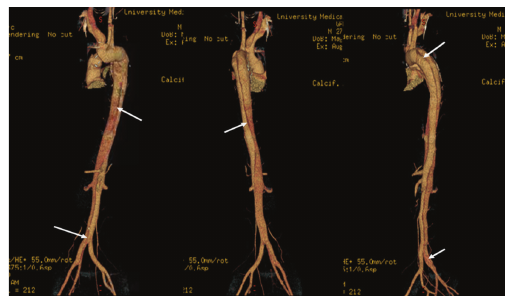
Figure 5: 3D reconstruction of the second aortic